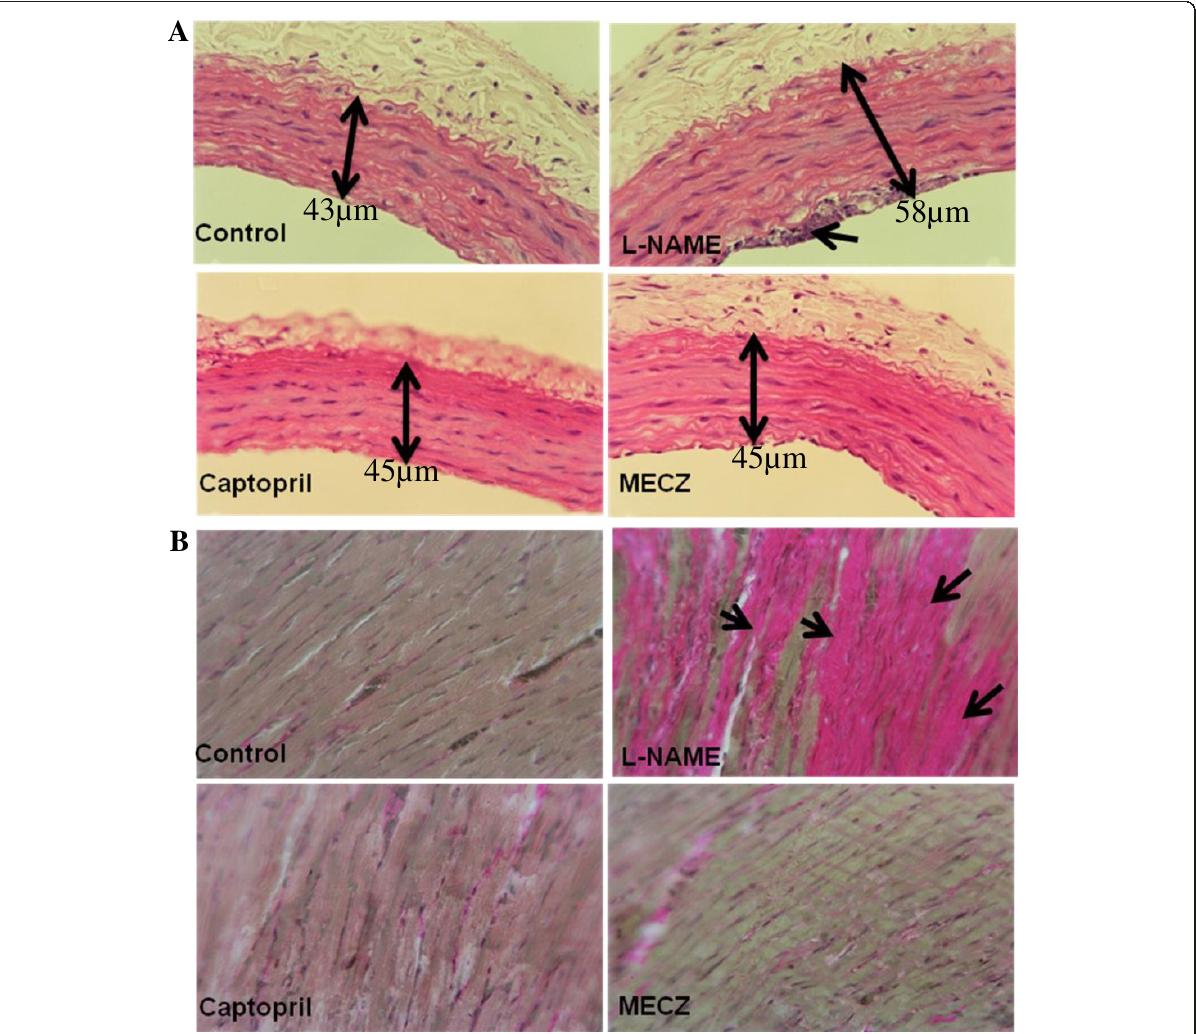
Figure 5 Representative photographs showing aortic and left ventricular histomorphologies respectively stained with Hematoxylin & Eosin and Van Gieson trichrome. Magnification: